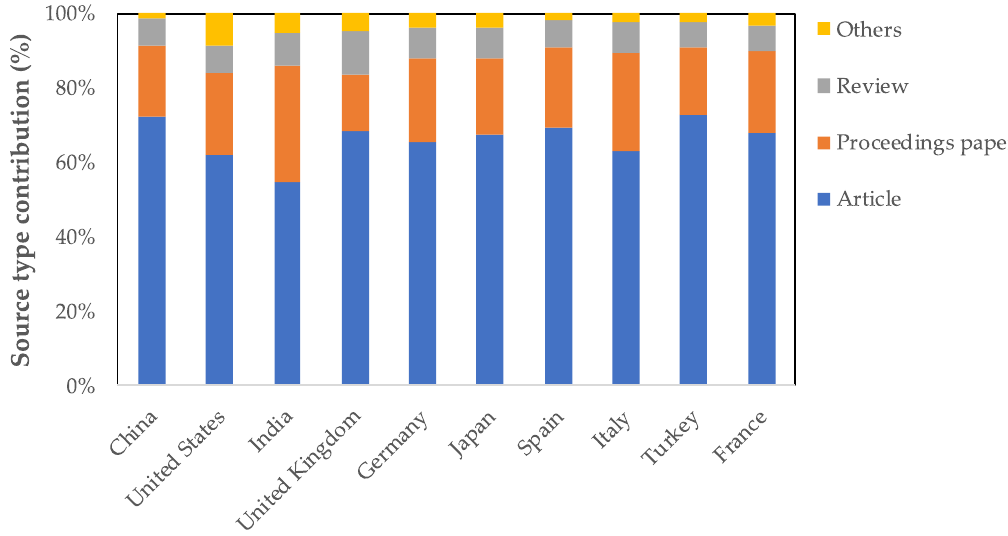
Figure 5. Most productive countries comparison in terms of source type contribution (between 1900 and 2020).